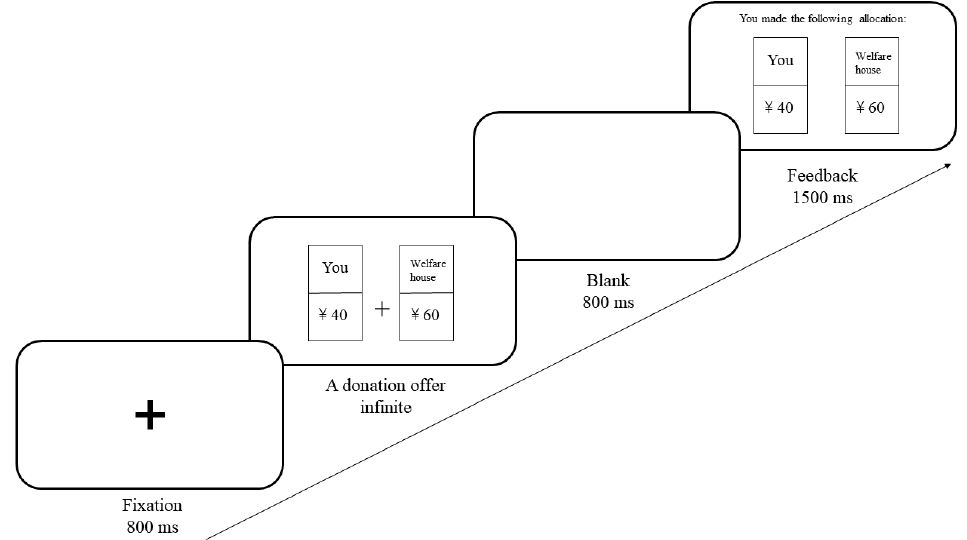
Figure 1. Flow diagram of a donation task trial.